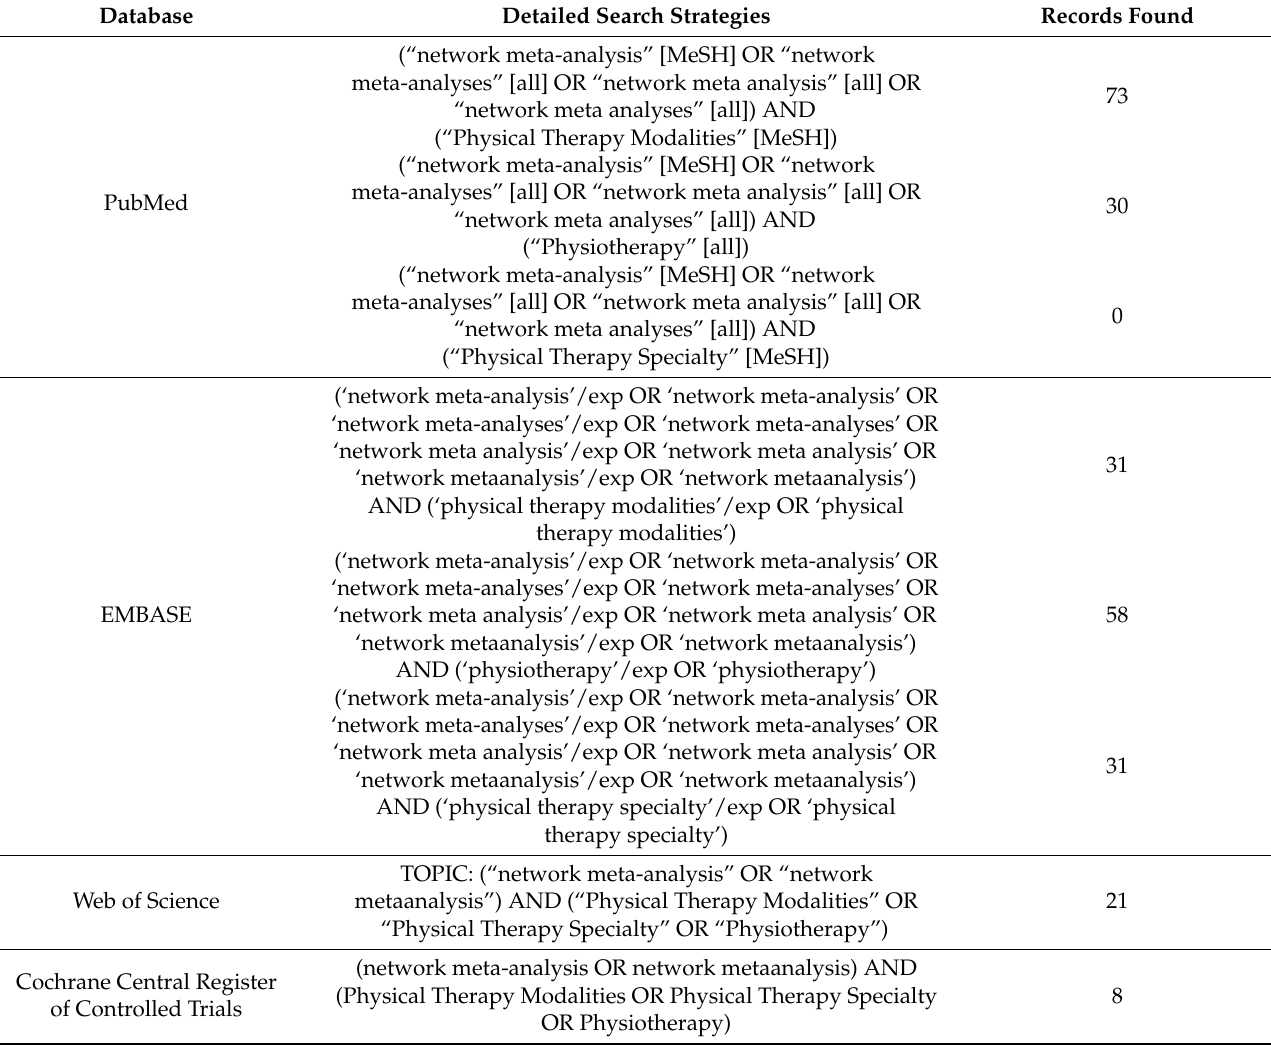
Table 2. Detailed search strategies for each